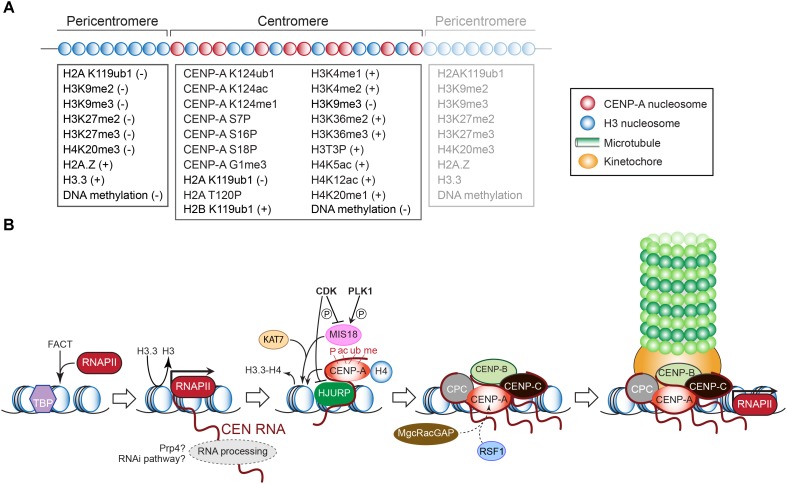
(A) Epigenetic modifications that mark histones and DNA (cytosines) in the pericentric and centromeric domains. The positive or negative signs indicate whether the modification underlies transcriptional silence or activity, respectively. Modifications of CENP-A required for its deposition or maintenance are also listed. See text for explanations. (B) Schematic outline of transcription-dependent inclusion of histone H3 variant CENP-A at the CEN chromatin, and recruitment of downstream kinetochore components as in vertebrates. See text for details.